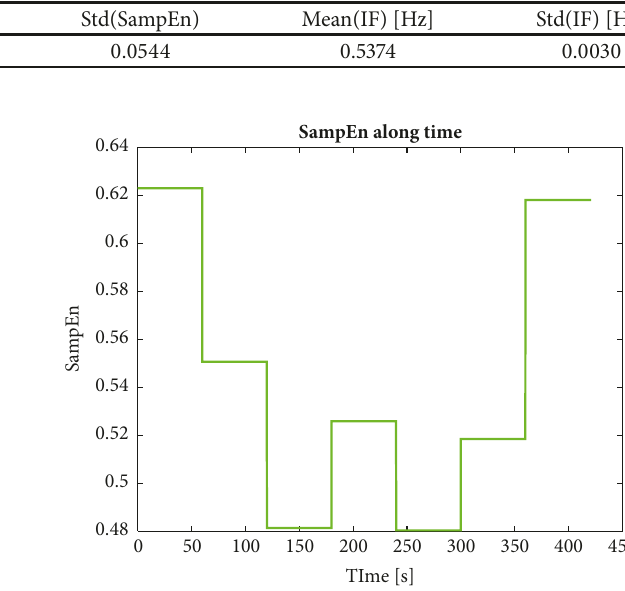
Table 2: Mean(SampEn), Median(SampEn), and std(Sampen) of the analyzed LPRM 2. Now the mean(IF) and std(IF) are included.